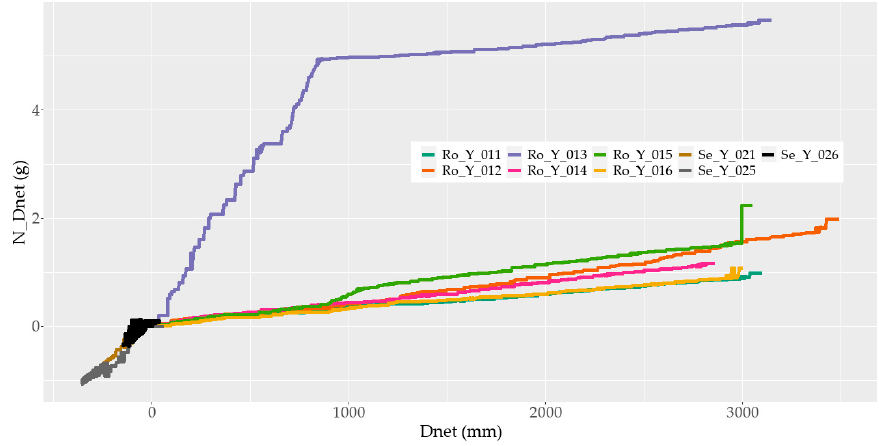
Figure 7. Cumulated net drained nitrogen (N_Dnet) versus cumulated net drainage (Dnet) in the Rollesbroich soil for the lysimeters in Selhausen, the water-limited site (W-limited) and the lysimeters in Rollesbroich, the energy-limited site (E-limited). Negative values correspond to periods when water and nitrogen was entering the system.